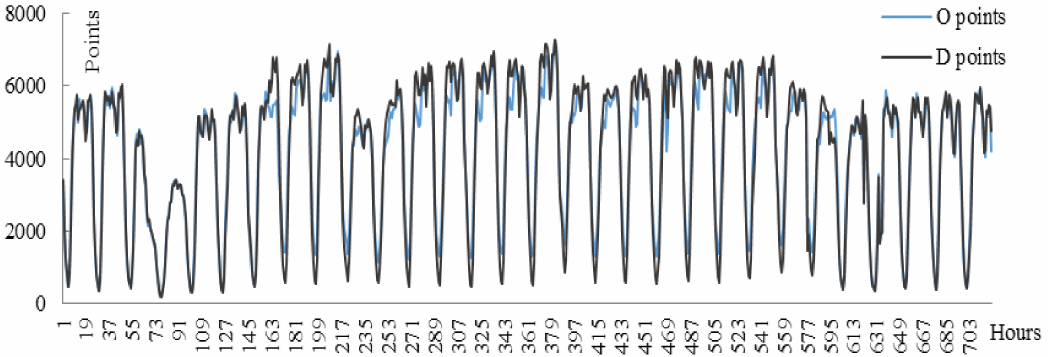
Figure 9. Curves of O points and P points representing the temporal variations of the taxi O/D flows over the entire study area. There are large numbers of O/D points that exhibit 24-h